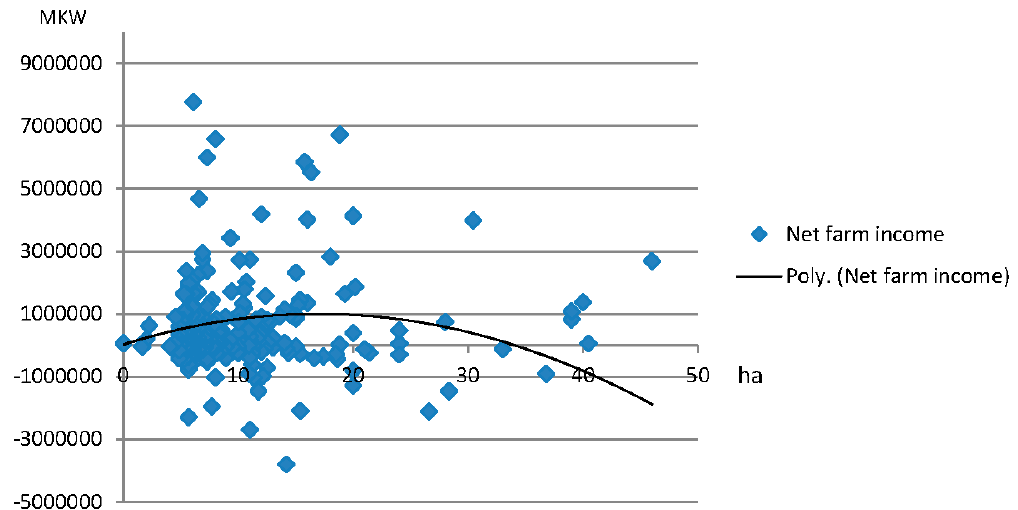
Figure 5. Productivity (net farm income) per hectare for the different sizes of farms ( N = 300). Source: